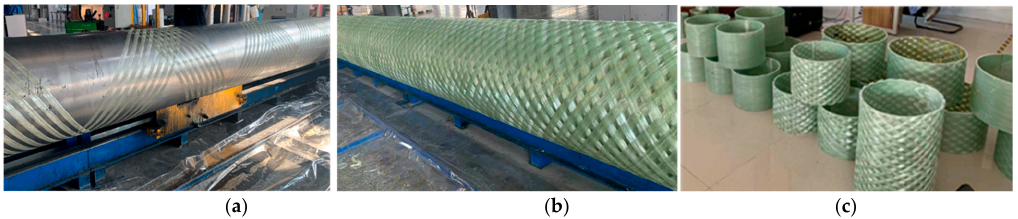
Figure 4. Manufacturing process of the proposed GFRP pipe specimens: ( a ) Wrapping impregnated GRFP; ( b ) GRFP pipe after wrapping; ( c ) GRFP pipe test specimen.